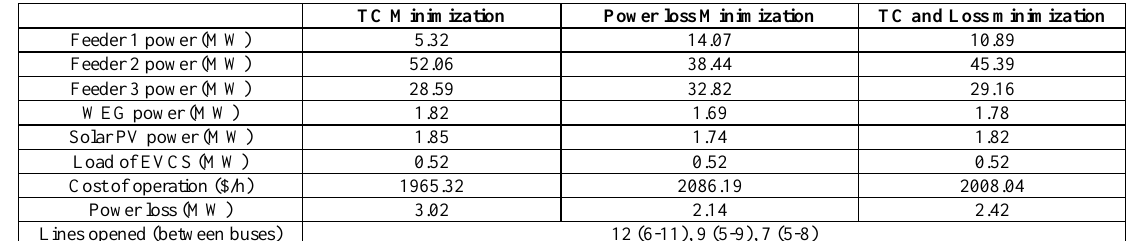
Table 1. Optimum power outputs for single and multiple objectives of 17 bus balanced